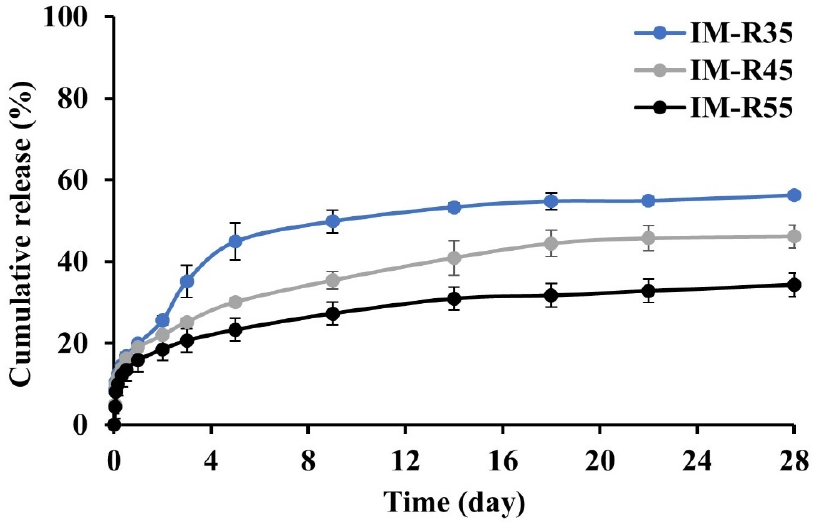
Figure 5. Effect of rosin concentration (35%, 45% and 55%) on IM release from IM-loaded rosin-based ISG formulations ( n = 6).